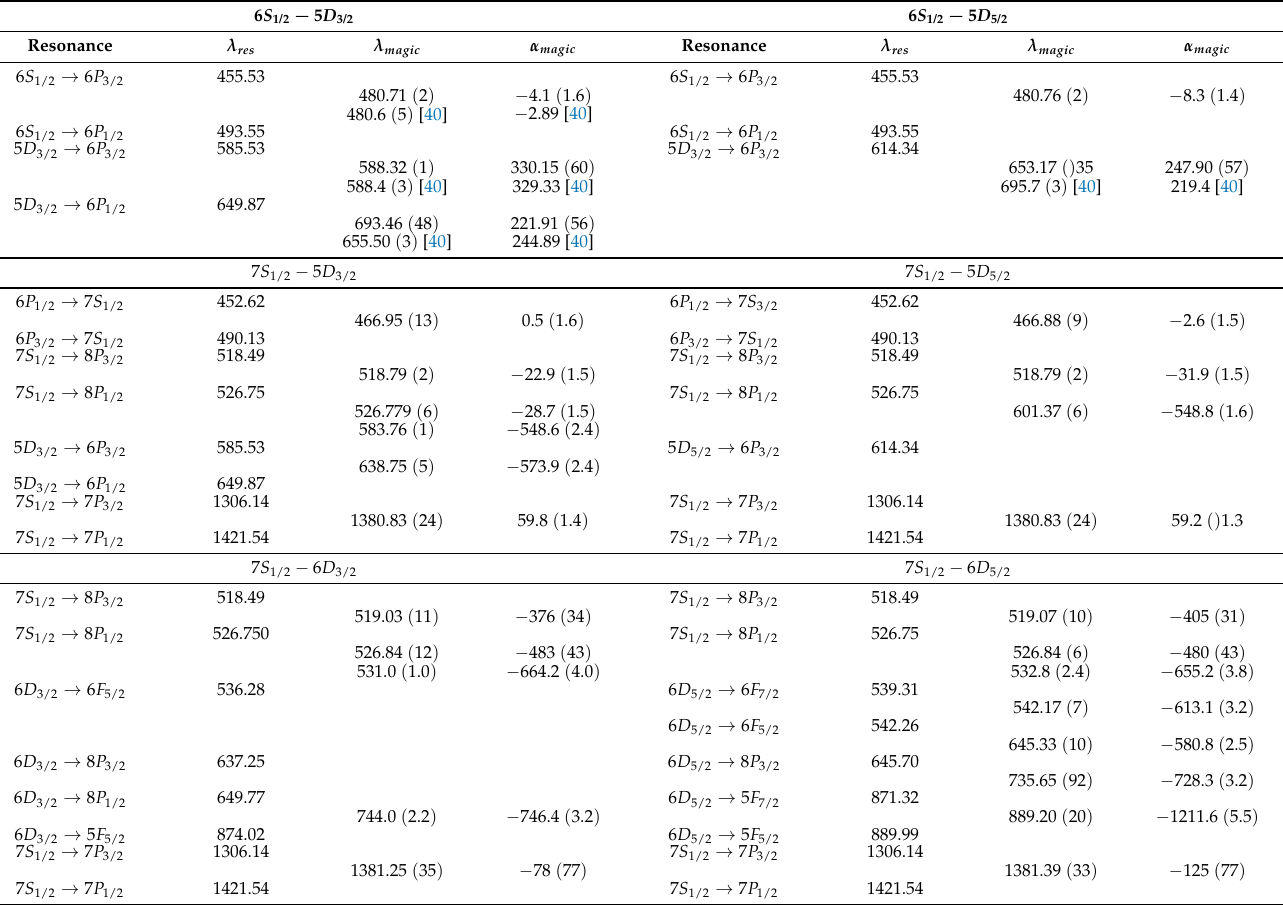
Table 4. Magic wavelengths λ magic (in nm) with their corresponding polarizability α n ( ω ) (in a.u.) along with their comparison with the available literature for ( 6,7 ) S 1/2 − 5 D 3/2,5/2 and 7 S 1/2 − 6 D 3/2,5/2 transitions in Ba + ions.